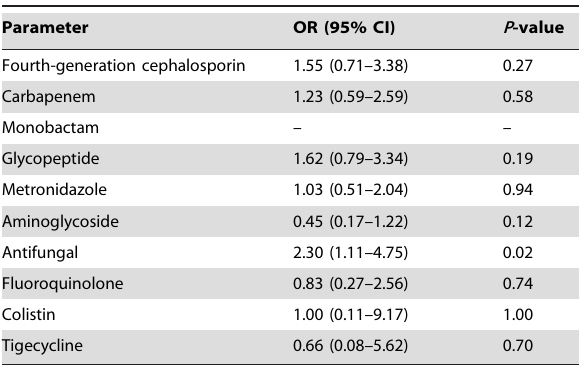
Table 2. Univariate analysis of risk factors for acquiring VRE during ICU